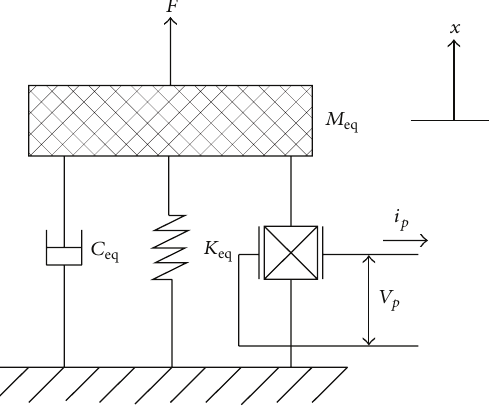
Figure 2: Equivalent mechanical model of the harvesting structure.